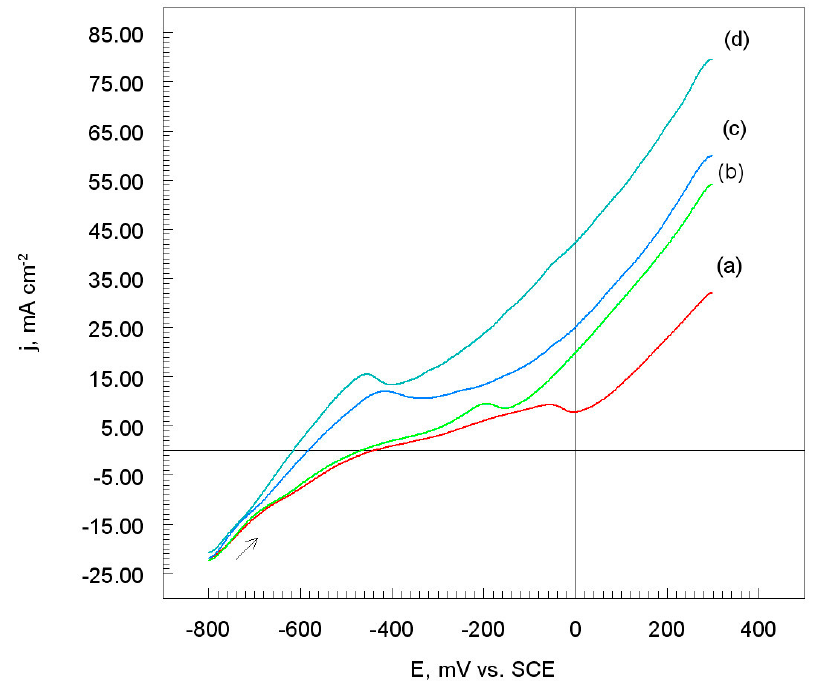
Figure 8. Potentiodynamic polarization curves for nickel coatings on the Al7075 substrate. Name powder / coating: ( a ) M28 ( b ) C30 , ( c ) A34 , and ( d ) O60 . Solutions contained 1.2 M Cl − , pH 1.5, d E / d t 1 mV s − 1 .